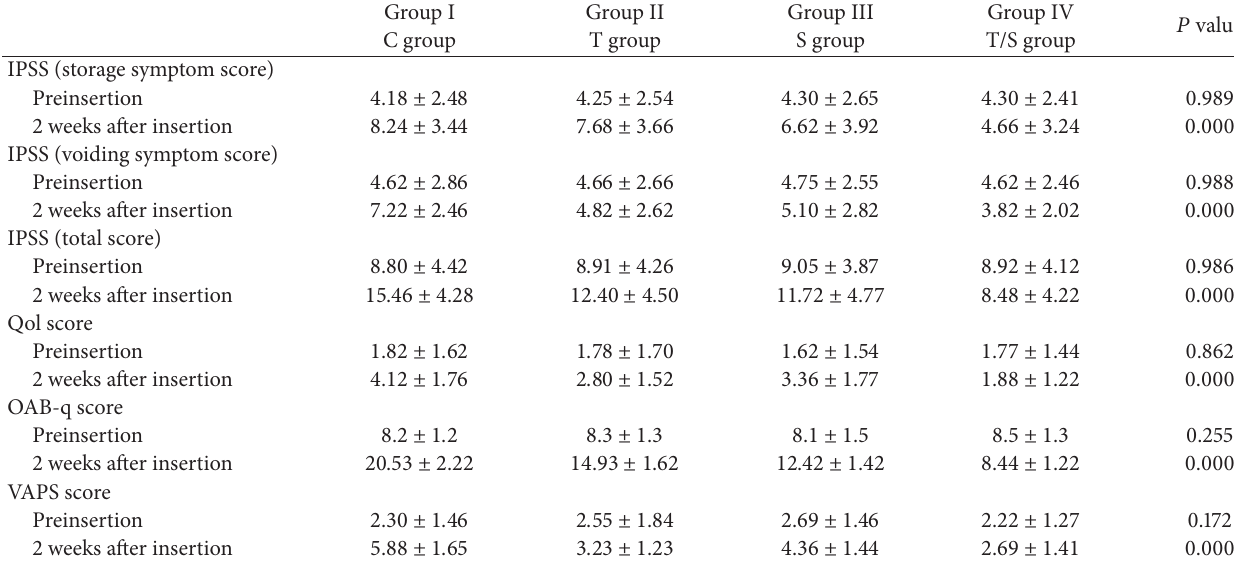
Table 2: Comparisons of IPSS/QoL, VAP scale, and OAB-q scores in all groups. Group I